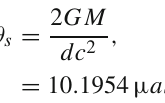
deski gravity black holes monotonically increases with a and Q for the both prograde and retrograde photon; and are of O ( mas ) for b = 10 4 M (cf. Table